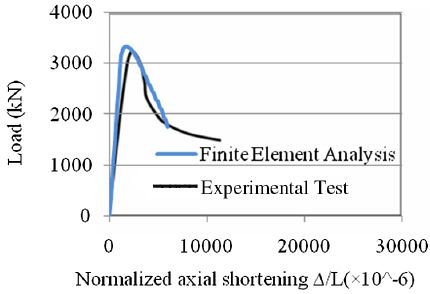
Fig. 6. Load versus normalised axial shortening curves for the stub columns